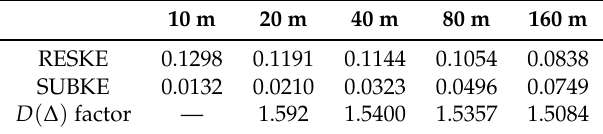
Table 3. Resolved kinetic energy (RESKE), subgrid kinetic energy (SUBKE) and the scaling factor of sub-filter energy with each successive doubling of ∆ for CBL1 simulations with different grid lengths.